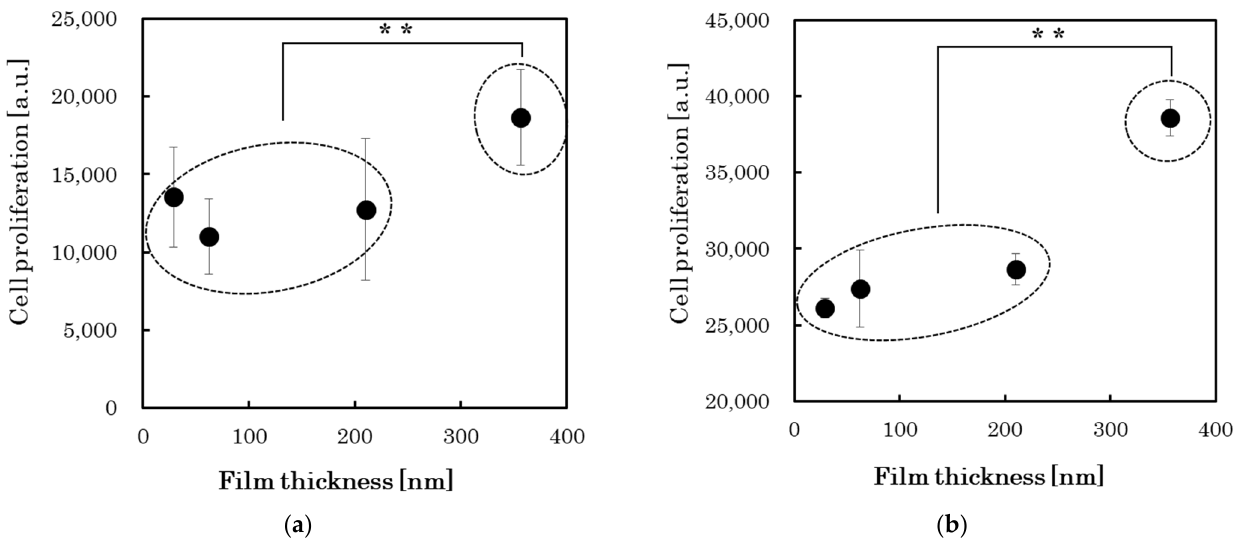
Figure 4. Cell proliferation of the PLC films with different thicknesses. ( a ) Fibroblasts (NIH-3T3);